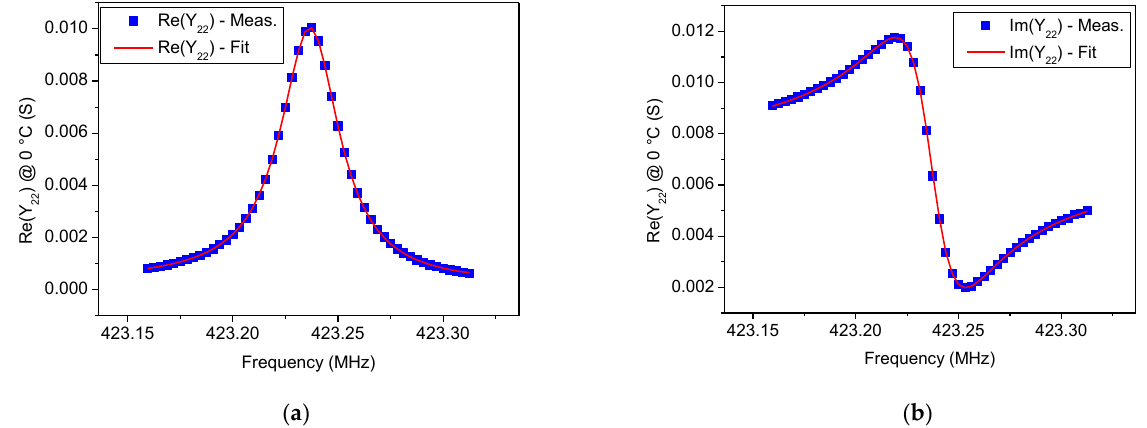
Figure 5. Comparison between measurements and Lorentzian fitting on the ( a ) Re( Y 22 ) and ( b ) Im( Y 22 ) for the tested SAW resonator at 0 °C.